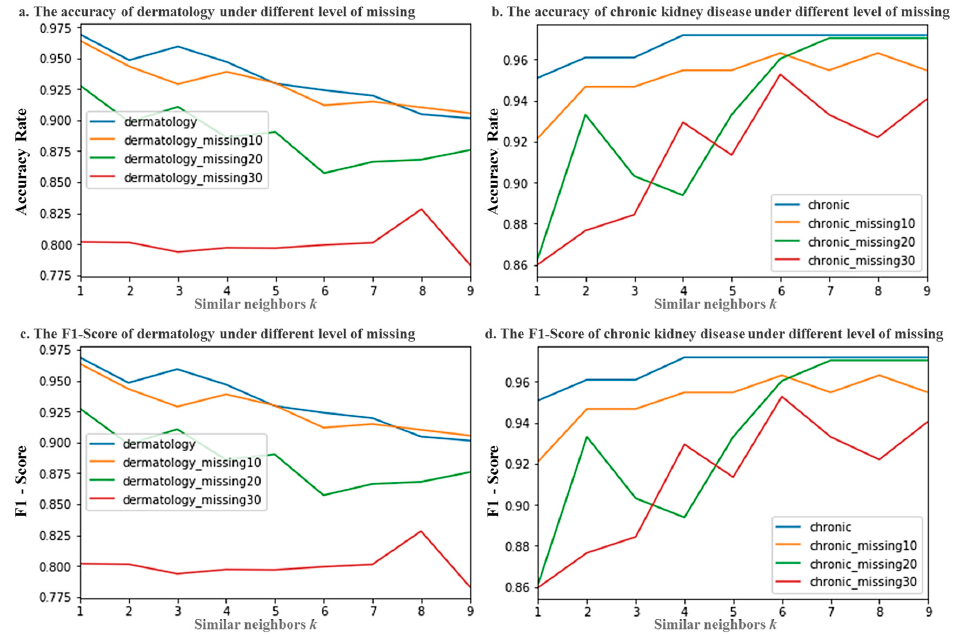
Figure 6. Experimental results of a user-based collaborative filtering model.